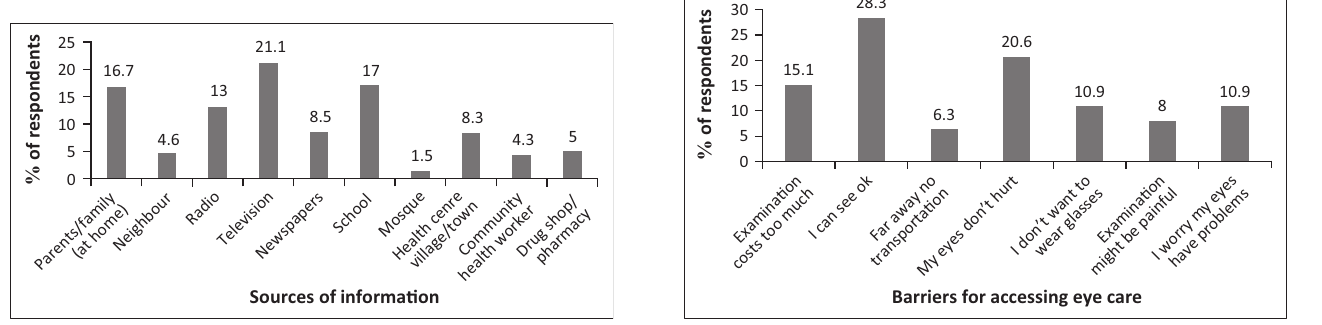
FIGURE 3: Sources of information about eye health.